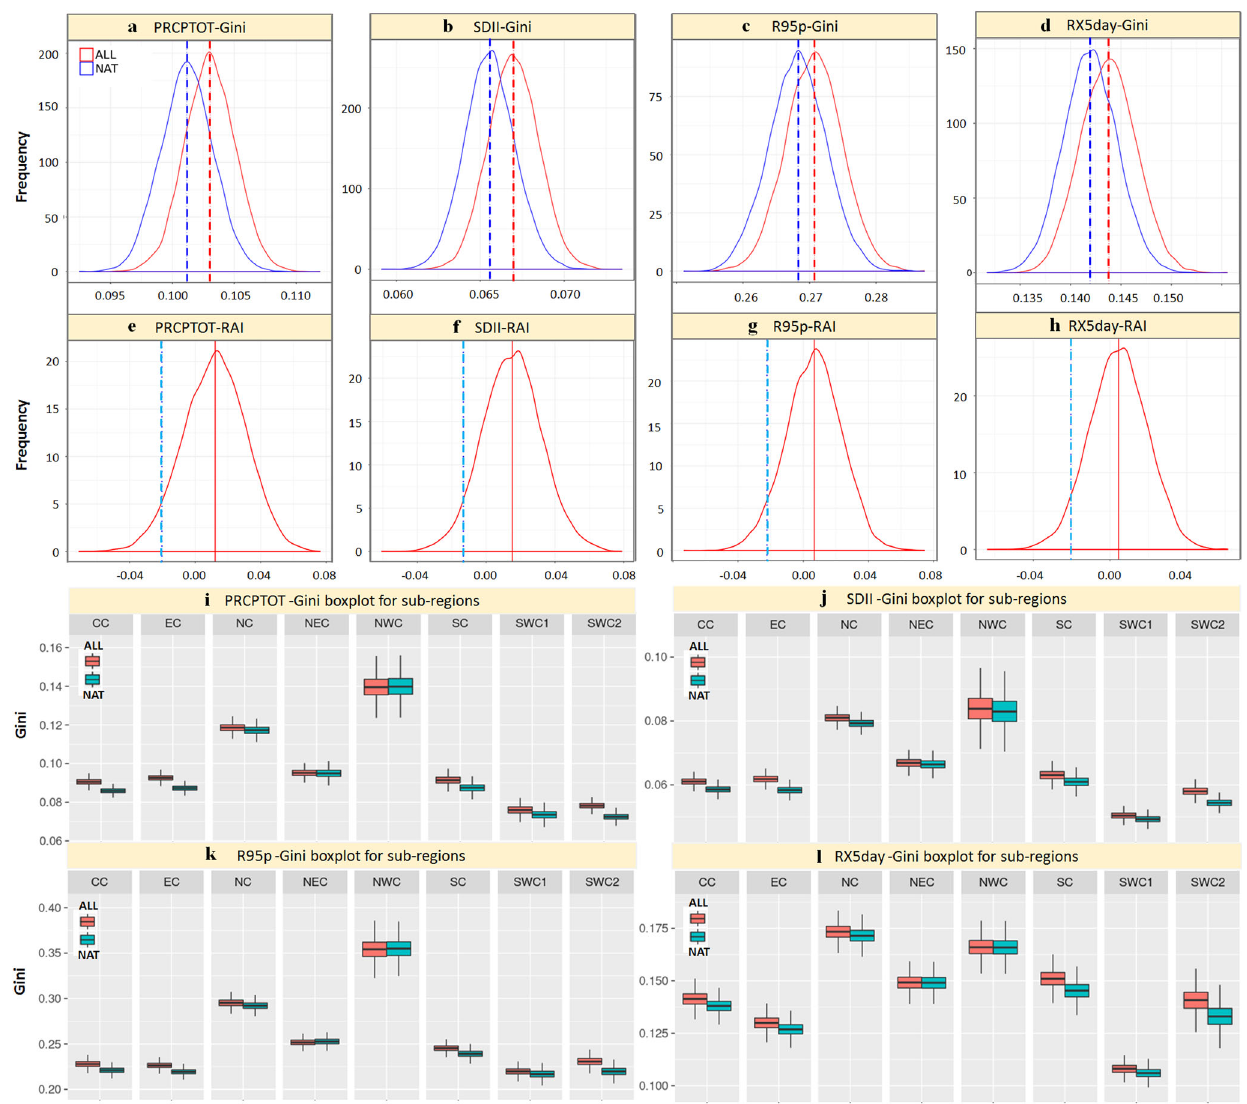
Fig. 2 Maps of the resampled averaged Gini-coef fi cients and RAI. a – d The probability distribution functions of the resampled averaged Gini-coef fi cients for four precipitation extreme indices over China for CMIP5 ALL and NAT scenarios obtained by the bootstrapping procedure and the dashed line indicates the median (best estimate) value of Gini-coef fi cients. e – h The probability distribution functions of RAI values over China, and the solid red line indicates the median (best estimate) value of RAI, and the dashed line indicates the fi fth percentile value; the i – l sub fi gures are the boxplots of the resampled averaged Gini-coef fi cients for eight subregions. The sub fi gures were done in the software R 4.0.2 (https://cran.r-project.org/bin/windows/) and then the sub fi gures were merged by using the Microsoft PowerPoint 2013 software similar features in eight regions, showing a stepped upward trend in most regions between SSP126, SSP370, and SSP585 simulations. For PRCPTOT projections, the best RFI is greater than zero in most regions under SSP370 and SSP585 scenarios, while less than zero in most regions under the SSP126 scenario. Of them, the best RFI value in CC, EC, SC, SWC1, and SWC2 regions indicate a statistically signi fi cant (95%